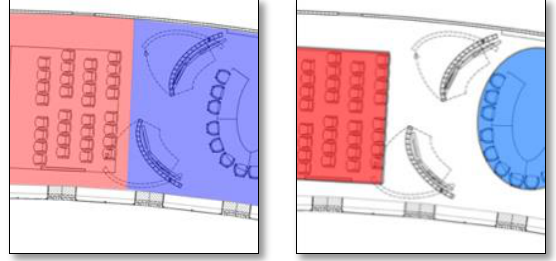
Figure 5: Subdivision types for localization on the floor plan: zone-type (left), functional- type